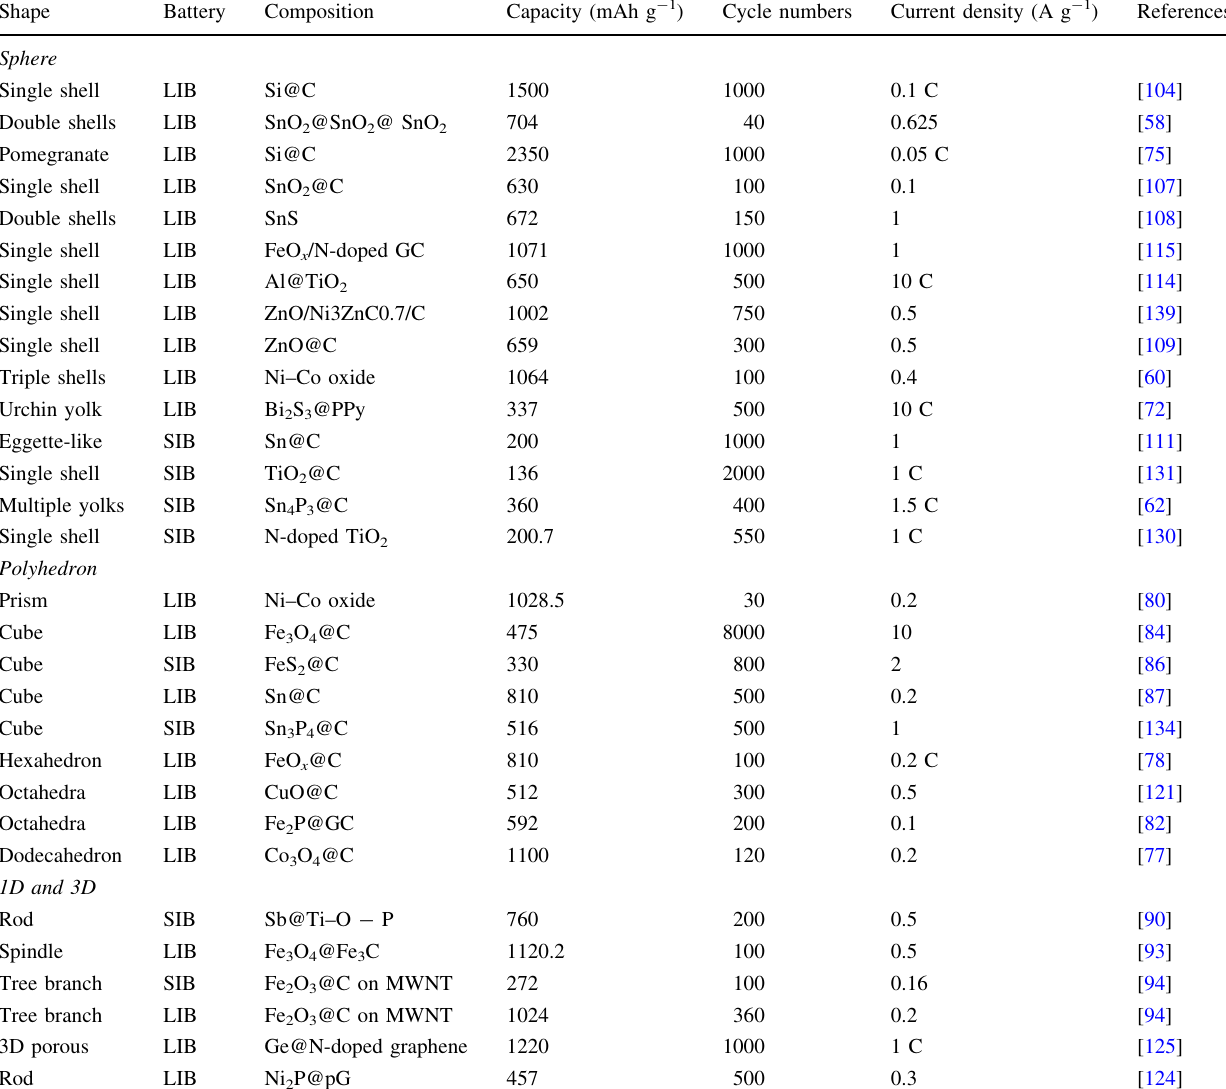
Table 1 Electrochemical performance of YS structured materials